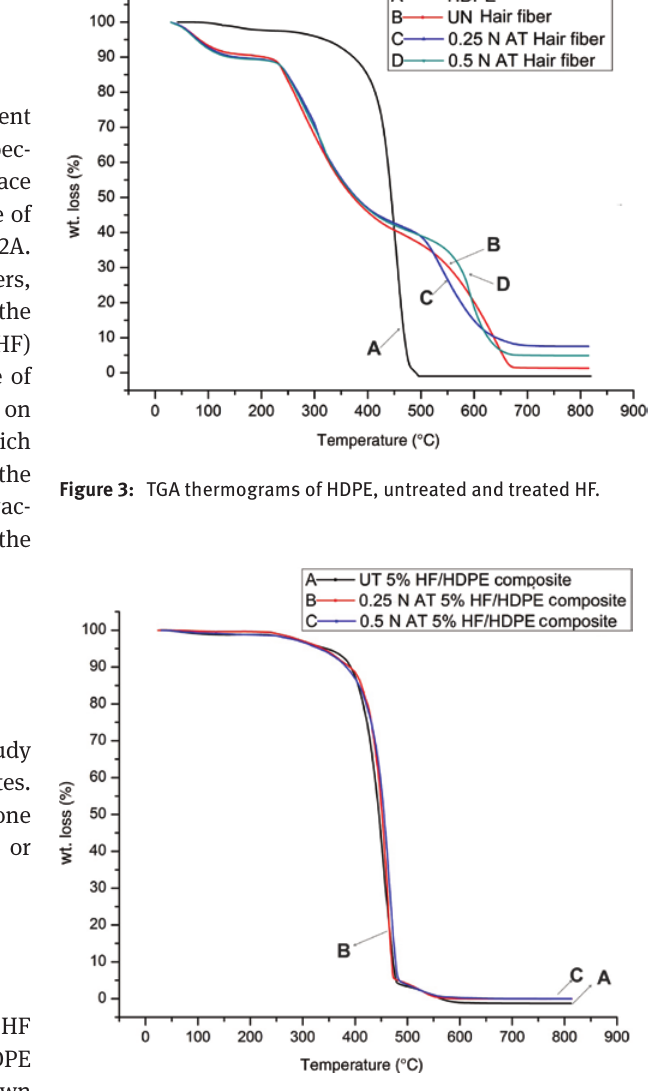
Figure 4: TGA thermograms of untreated and treated 5% HF/HDPE